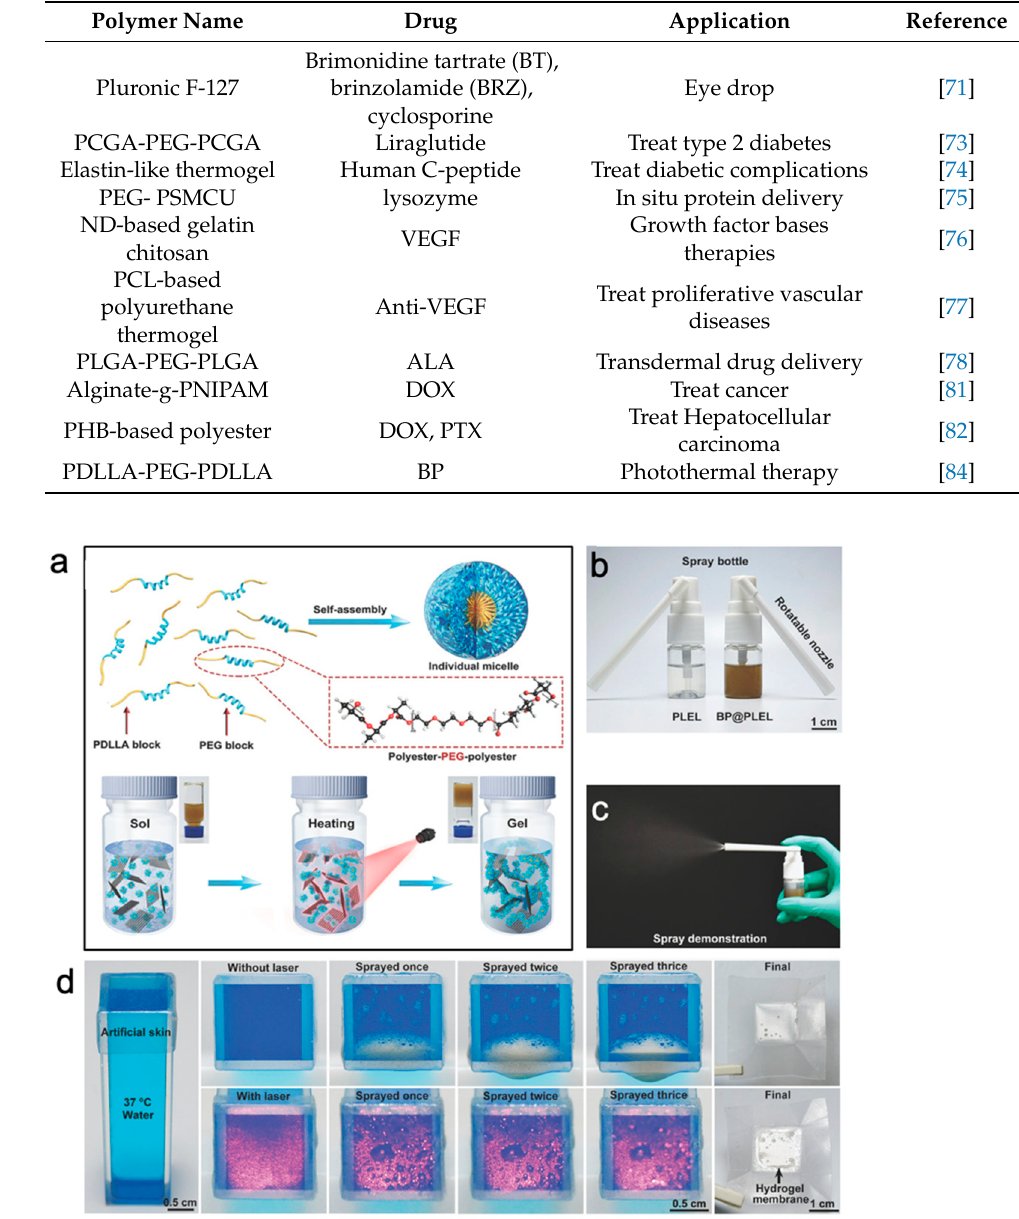
Table 2. Thermogel systems for drug delivery.